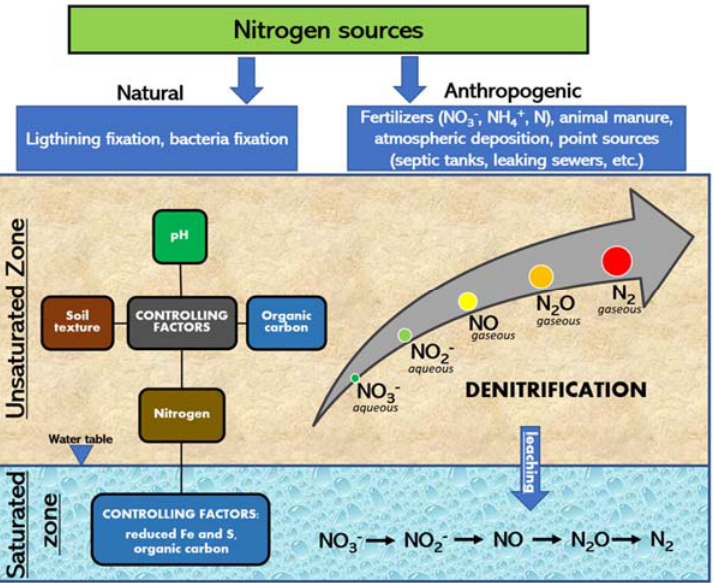
Figure 1. Conceptual model of DNT occurring in the unsaturated and saturated zones.